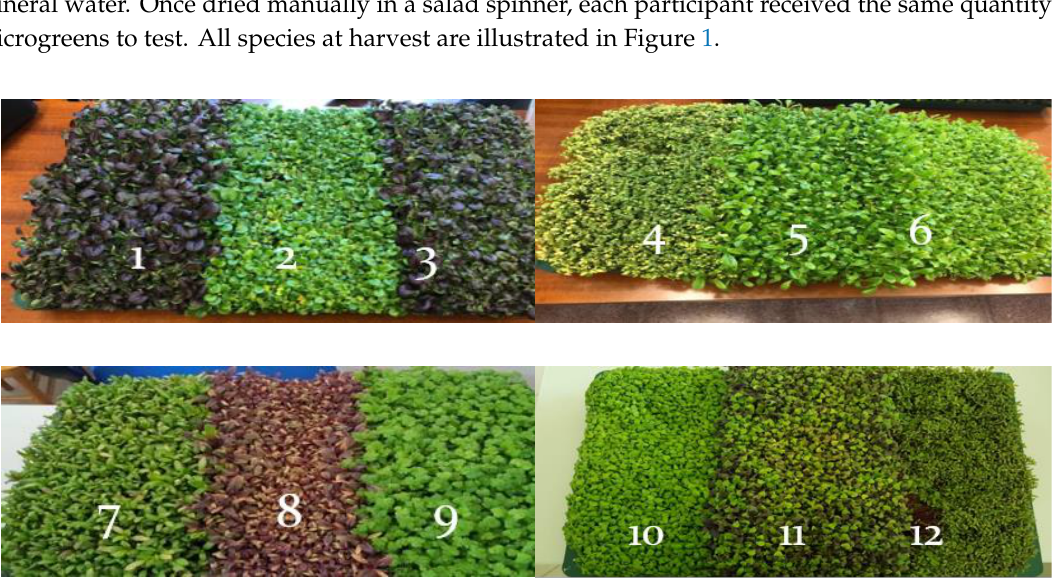
Figure 1. Optical images of the evaluated microgreens species (1. Komatsuna; 2. Tatsoi; 3. Pak choi; 4.